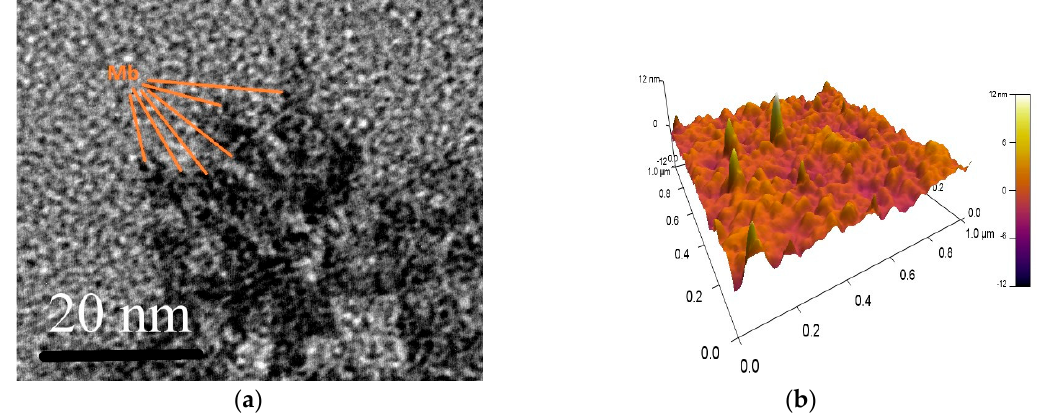
Figure 2. ( a ) TEM images of a Mb cluster deposited under conditions of optimal Hb immobilization; ( b ) AFM image of the Mb film deposited under corrected conditions.